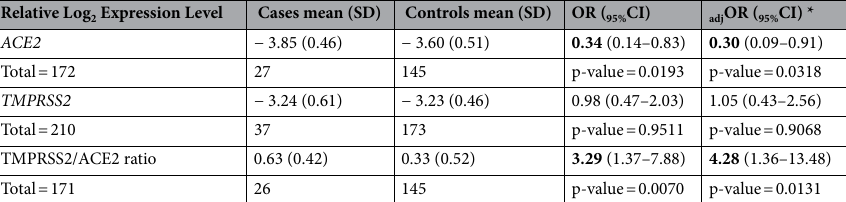
Relative Log 2 Expression Level Cases mean (SD) Controls mean (SD) OR ( 95% CI) adj OR ( 95% CI) * ACE2 − 3.85 (0.46)